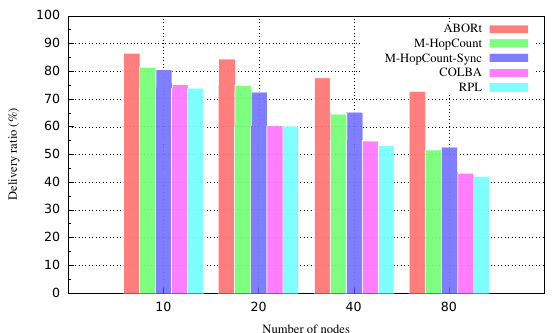
Figure 3. Packet delivery ratio for 1 pkt/sec/node.